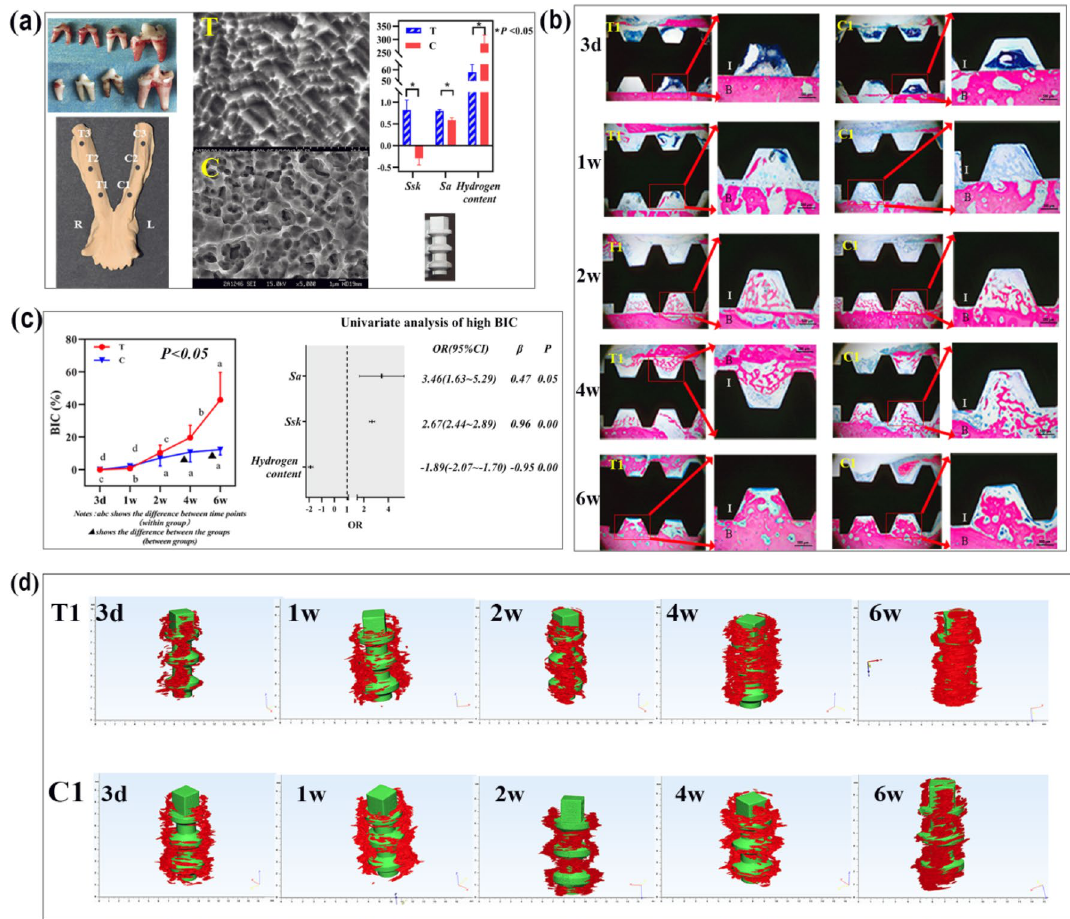
Figure 1. Variations in implant surface micromorphology impact bone-implant contact (BIC). ( a ) Four mandibular premolars of beagle dogs were extracted; SEM images of the surface micromorphology of the implants, etched by either formula T or formula C; the implantation sites. Ssk , Sa and hydrogen content of implant T and C. ( b , c ) Pathological features of new bone adjoined to the implants of groups T1 and C1. The BIC of group T1 was higher than group C1 at 4 w and 6 w after implantation; I: implant; B: bone tissue ( P < 0.05). Ssk and Sa resulted in high BIC, accounting for 96% and 47%, respectively, of all factors ( OR > 1, β > 0); the low hydrogen content led to high BIC ( OR < 1, β < 0). ( d ) The quantity of the new bone formed surrounding the implants of group T1 was more than that of group C1 at 4 w and 6 w after implantation ( P < 0.05). This figure was generated by Adobe photoshop CC